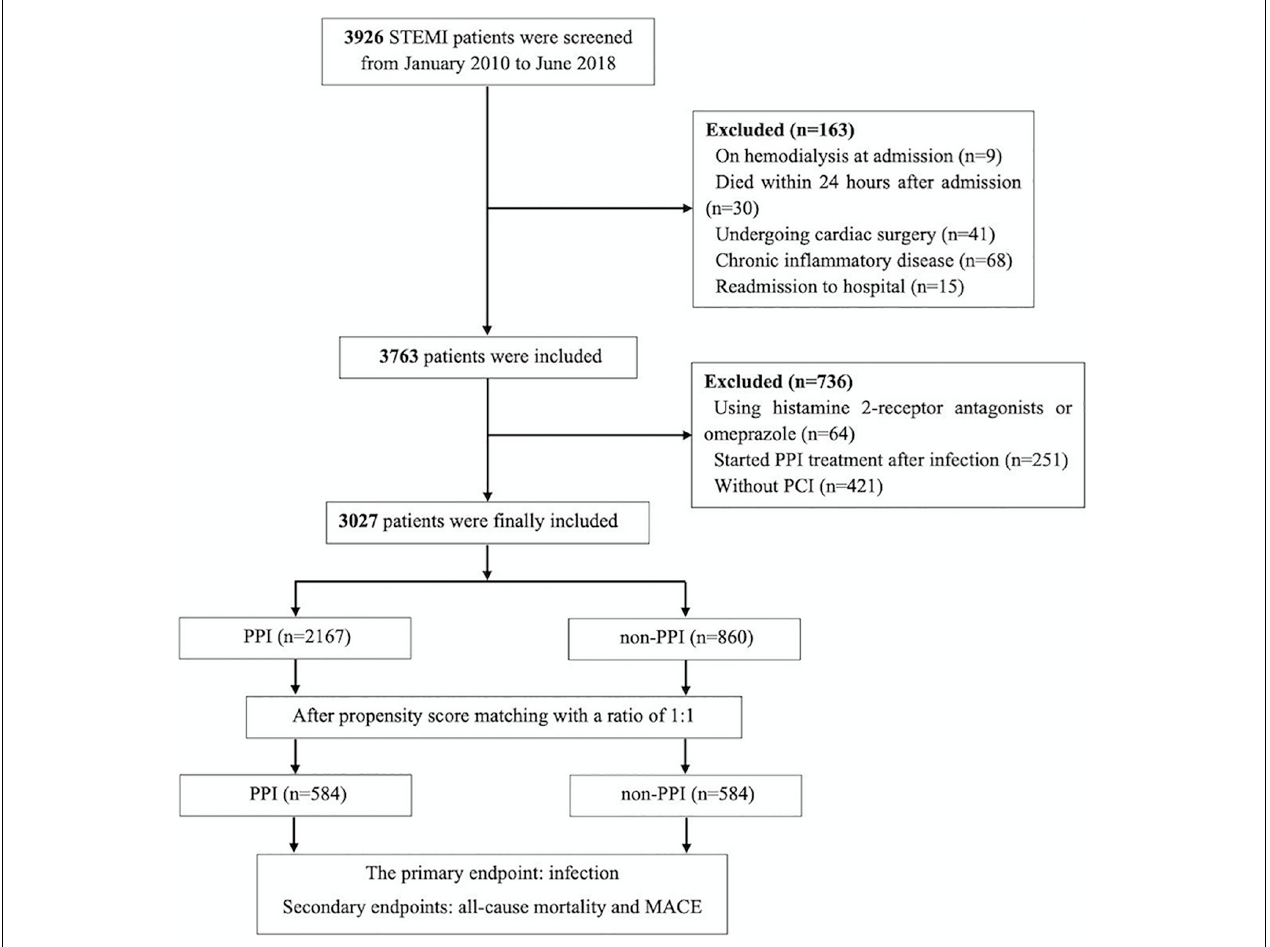
FIGURE 1 | The study flow diagram.